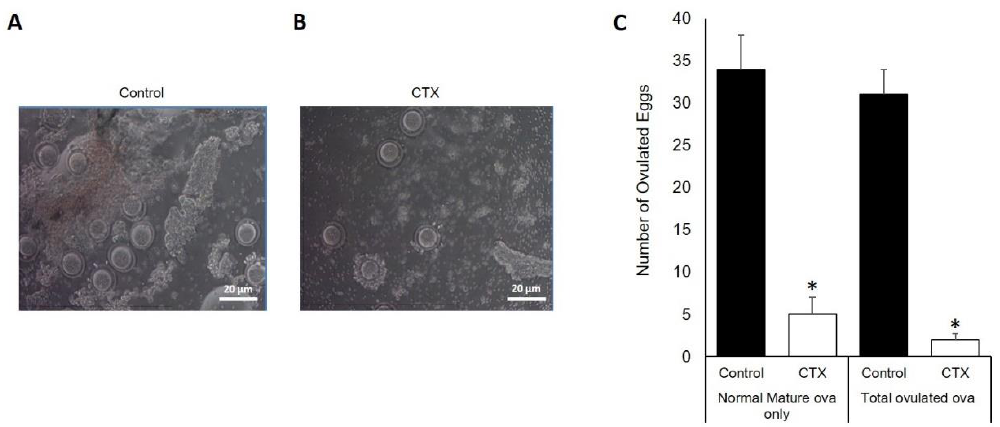
Figure 4. Chemotherapy effects on ovarian stimulation and follicular development. Microscopic illustration of mouse oocytes from control ( A ) and CTX ( B ) exposed mice; ( C ) graph bar summarize the number of ovulated ova after gonadotropins injection in both the CTX-treated group of mice and the control group (* p < 0.05).